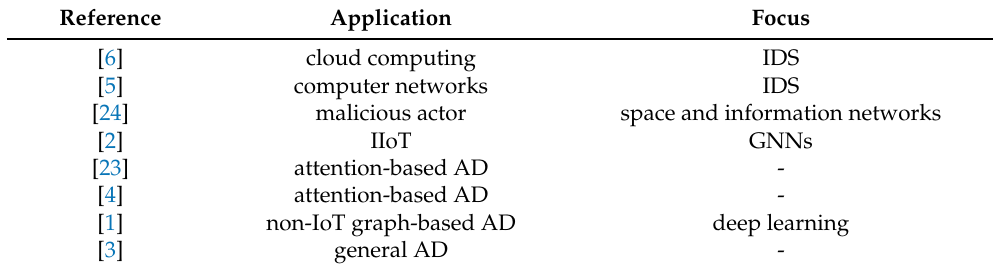
Table 1. Breakdown of application types for AD from related